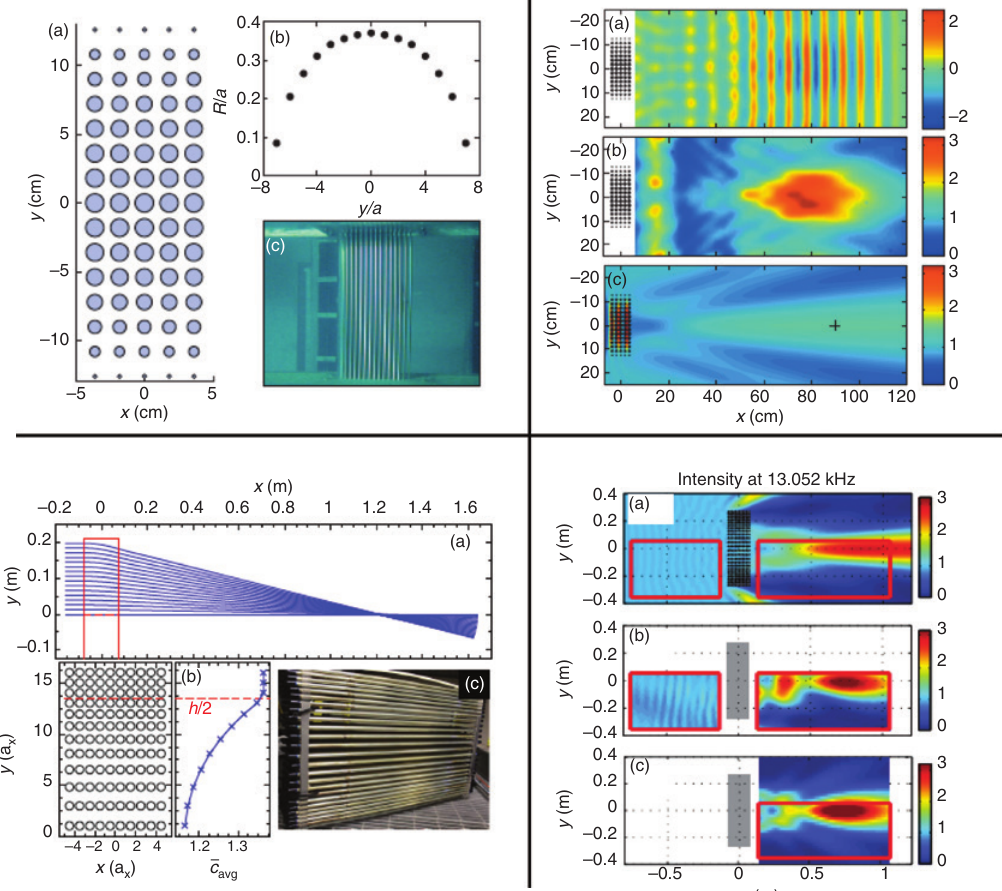
Figure 5: GRIN flat lens with phase delay and advance approaches. Upper left panel: Schematic view of GRIN flat lens with radius-varied steel cylinders embedded in water. Upper right panel: Normalized pressure amplitude from the source (a), measured normalized pressure intensity after the GRIN lens (b) and the same pressure intensity map using MST (c) [93]. Lower left panel: Schematic view of GRIN flat lens made of the same hollow air-filled aluminum tubes with anisotropic lattice spacing. Lower right panel: Sound pressure intensity at 13.05 kHz from 2D MST (a), experiment (b) and 3D Rayleigh-Sommerfeld approximation (c)